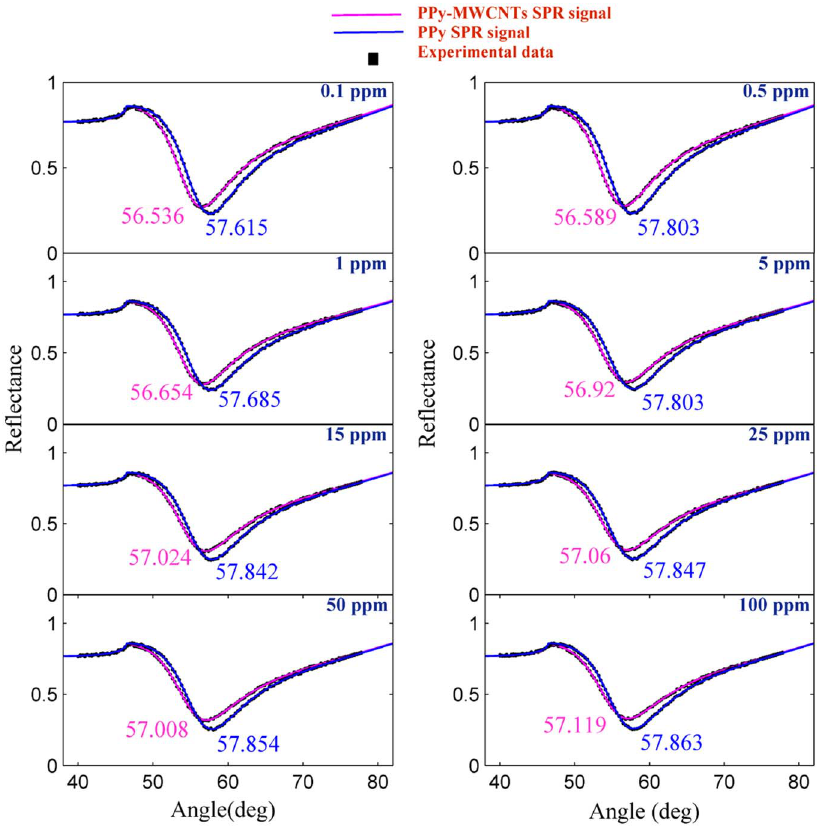
Figure 4. SPR signals to detect the Hg ion in an aqueous solution at the saturated values. doi:10.1371/journal.pone.0093962.g004 PLOS ONE |